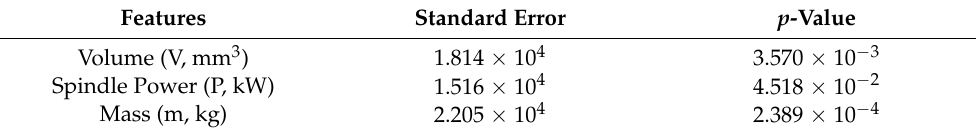
Table 7. Standard errors and p -values for multi-company cost (price) model (found in Equation